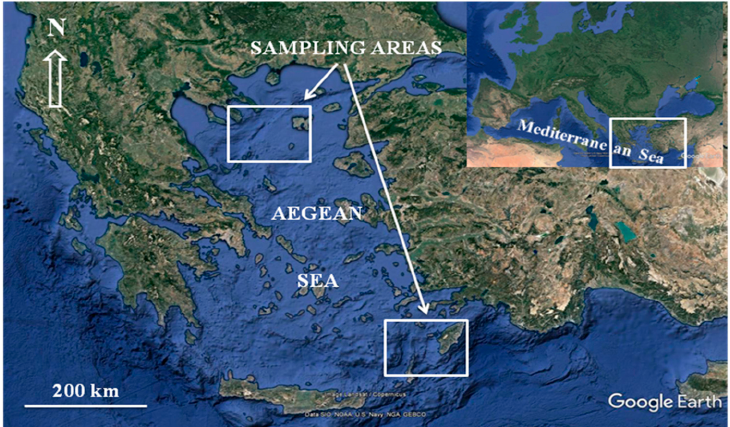
Figure 1. Sampling areas of the albacores (Northern and Southeastern Aegean Sea—Greece).